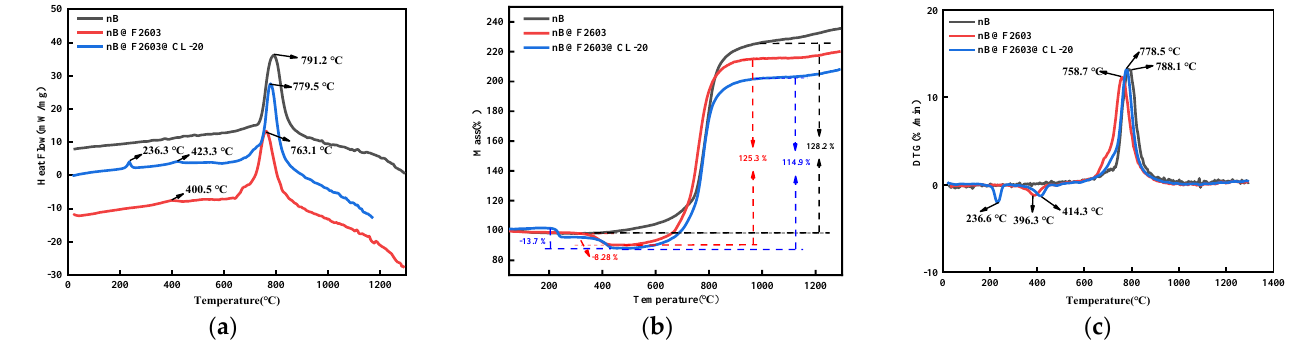
Figure 7. ( a ) DSC, ( b ) TG, and ( c ) DTG curves of n-B, nB@F2603 microspheres, and nB@F2603@CL- 20 microspheres.